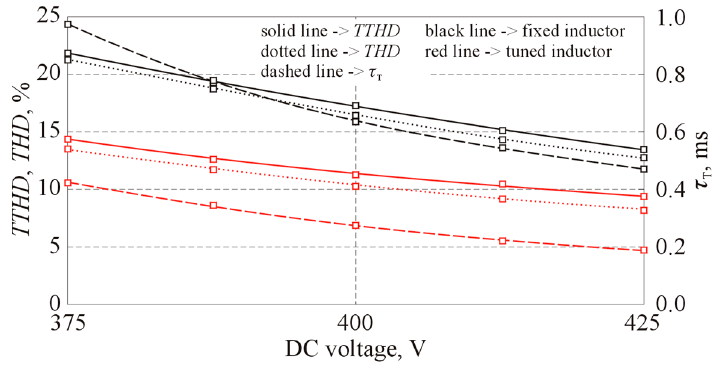
τ vs. the DC voltage. Figure 11. Curves for TTHD , THD , and τ T vs. The DC voltage.